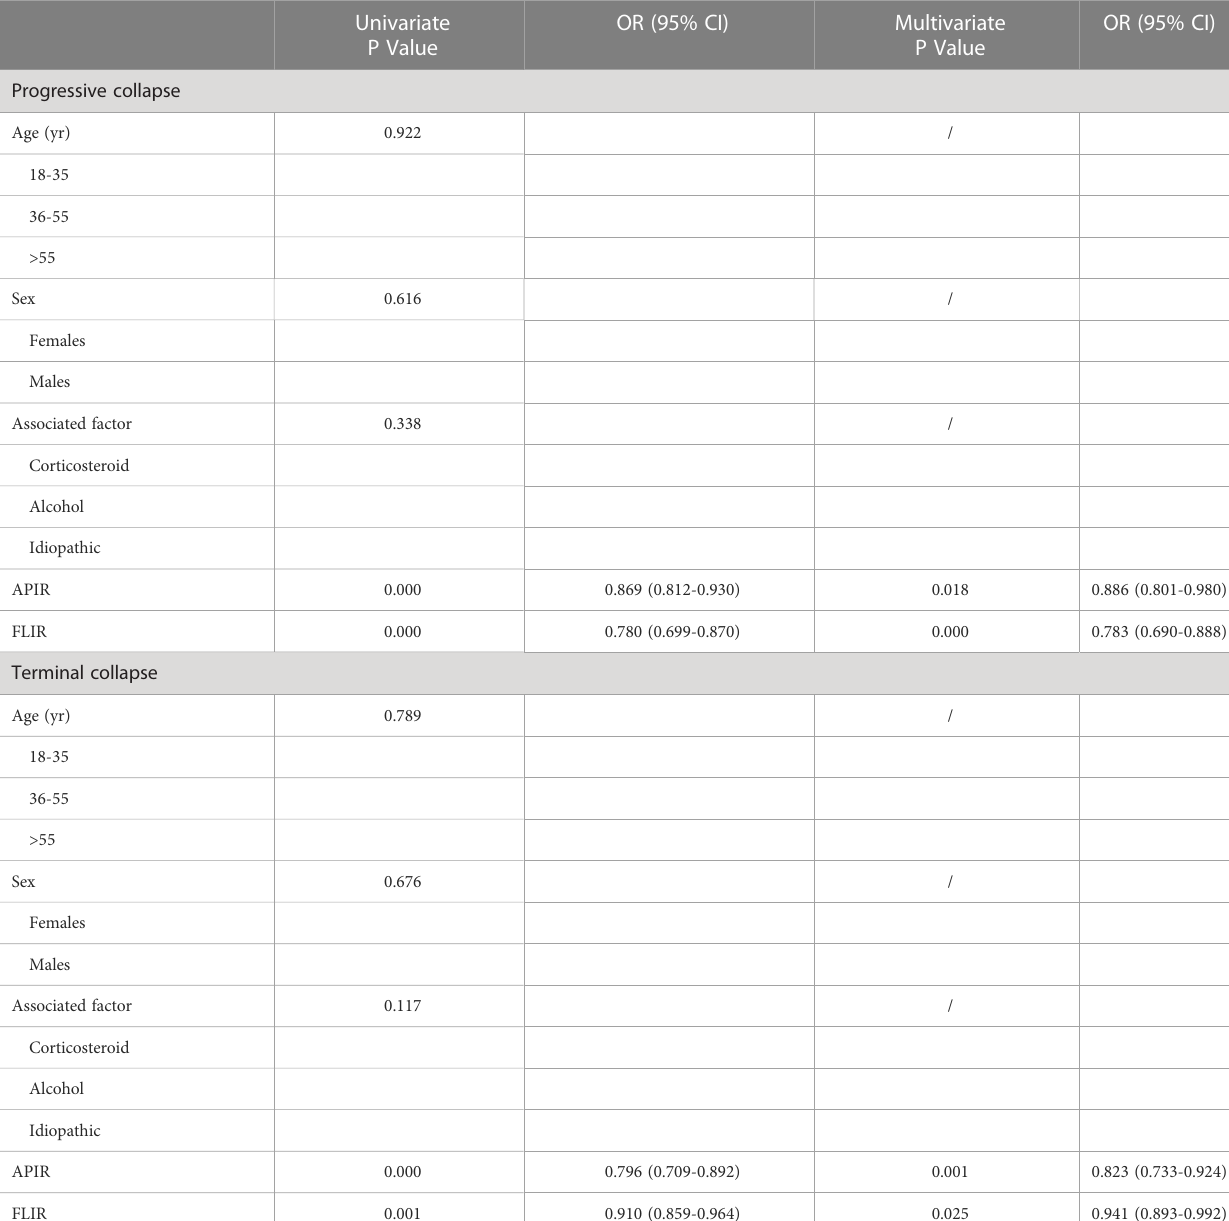
TABLE 4 Analysis of Independent Risk Factors for APIR and